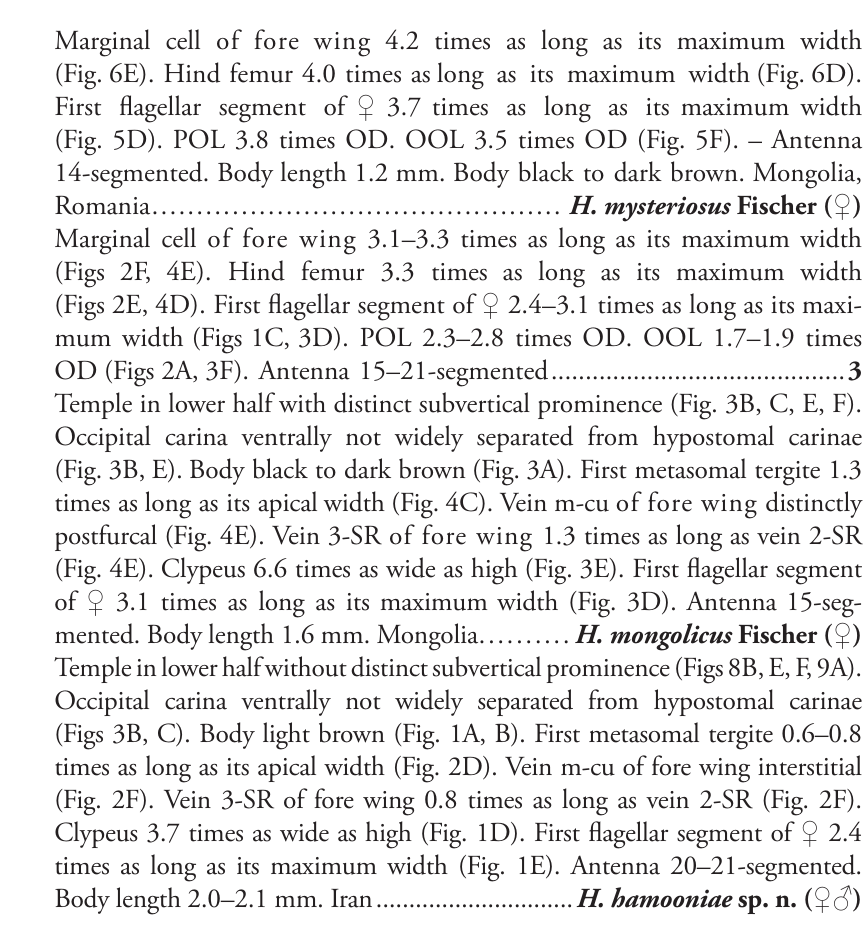
times as long as its maximum width (Fig. 1E). Antenna